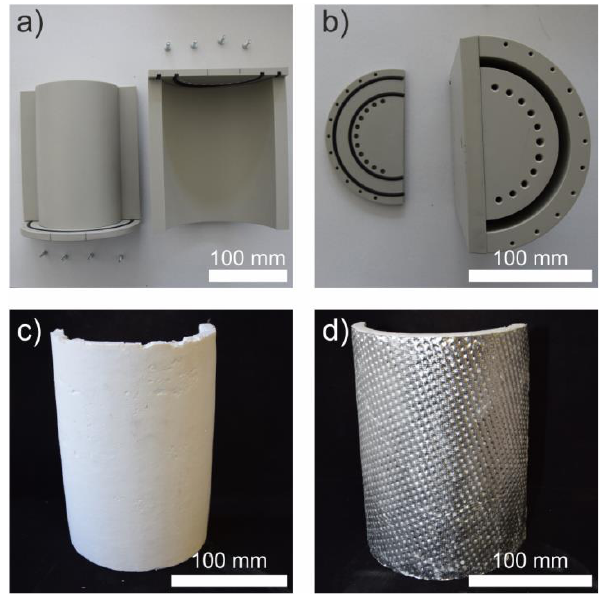
Figure 8. Photographs of the casting molds used to produce the ( a , b ) half-pipe-shaped composites and the finished half pipe prototypes after supercritical drying ( c ) without and ( d ) with an aluminum cover.